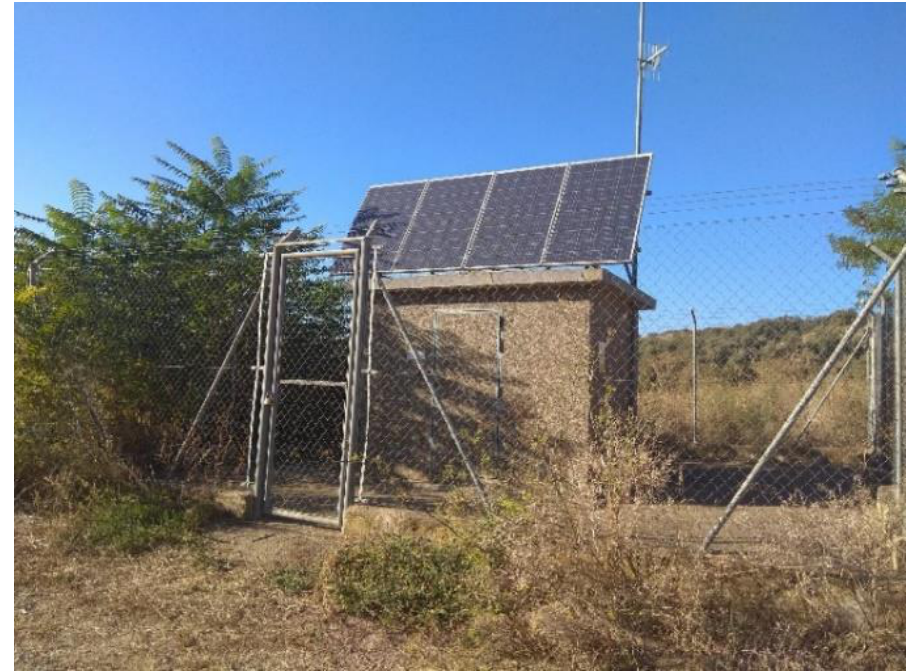
Figure 1. Standalone photovoltaic (PV) installation with metering and communication Figure 1 . Standalone photovoltaic (PV) installation with metering and communication equipment.